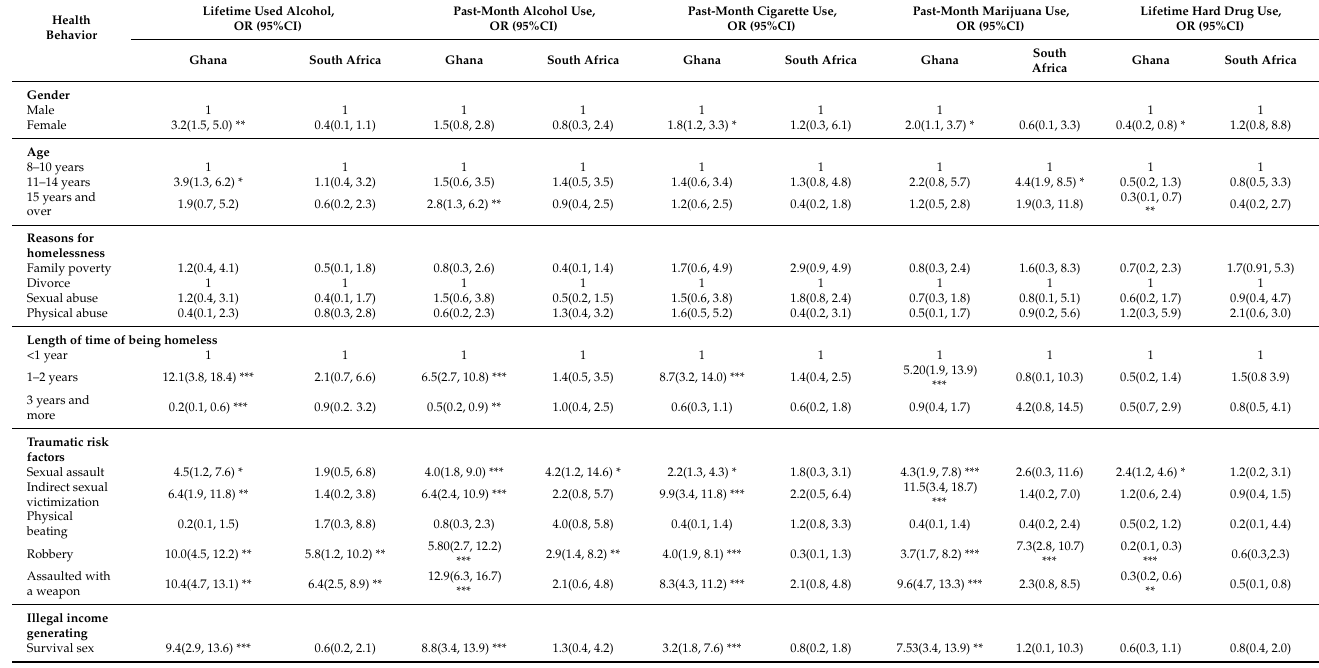
Table 2. Odds ratio and their 95% confidence interval of sociodemographic and psychosocial characteristics predictors of substance use in Ghana and South